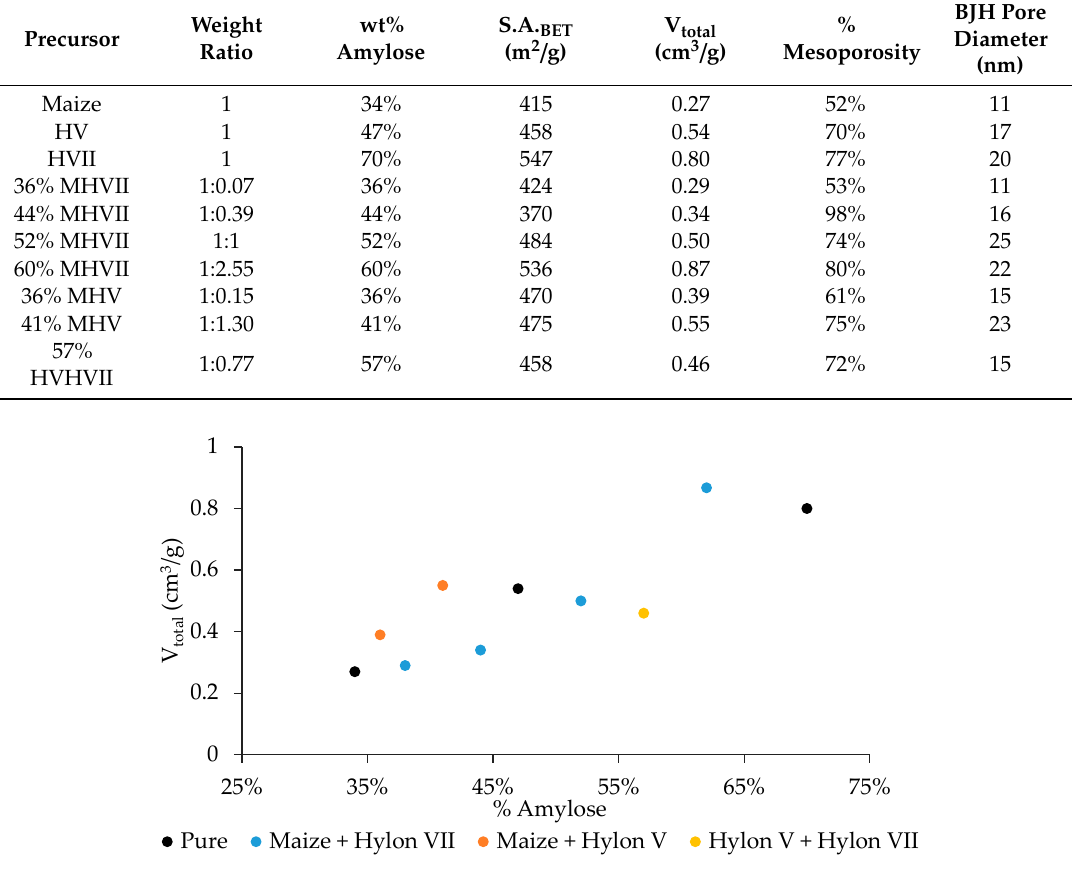
Figure 2. Graphic of the total pore volume against percentage of amylose (w/w) for different starches and their mixtures, prepared by an IL treatment and a modified Starbon ® based process, carbonized at 800 °C.